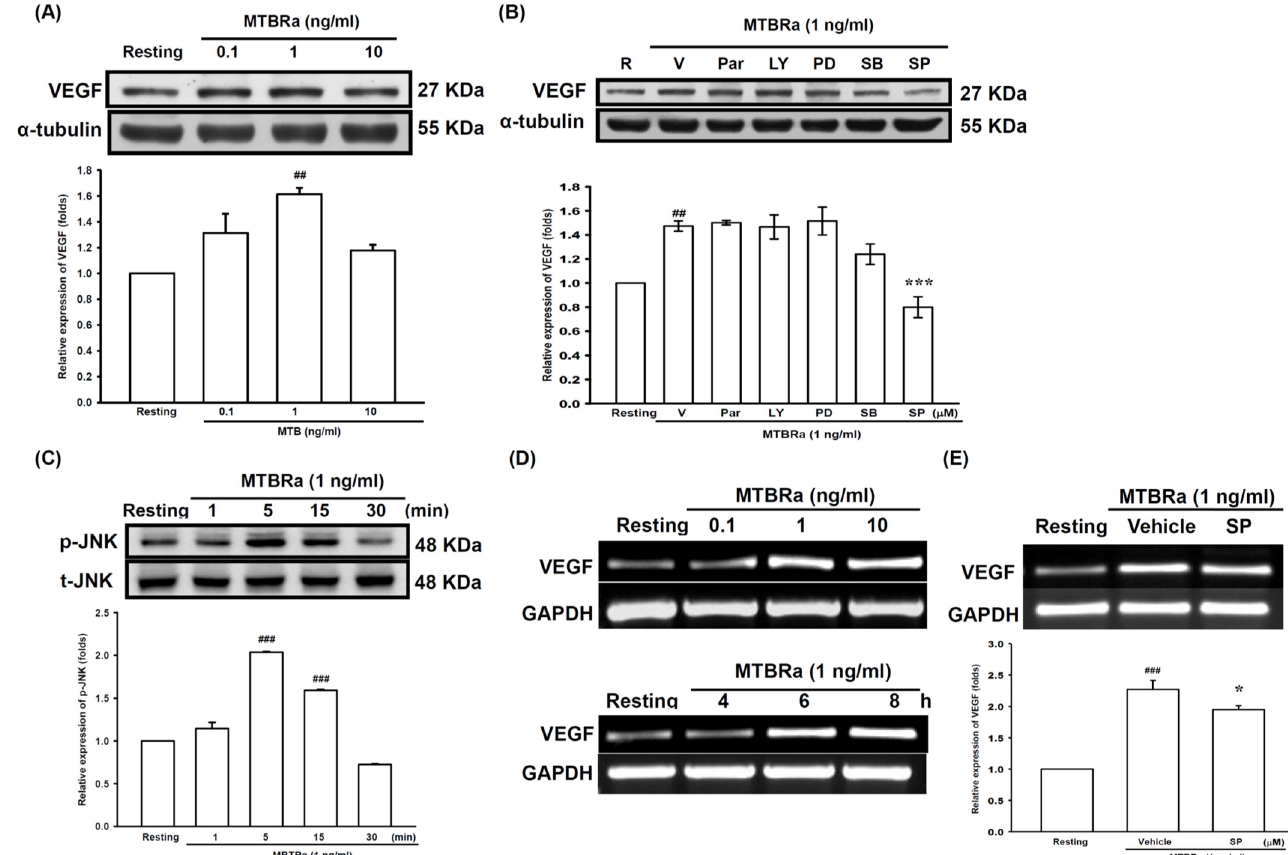
Figure 2. MTBRa induces VEGF expression in human PMCs through JNK signaling. ( A ) MeT-5A cells were treated with MTBRa (0.1–10 ng/ml) for 24 h. VEGF protein was assayed by Western blotting. ## p < 0.01 compared with resting group; ( B ) MeT-5A cells were pretreated with vehicle (V), Parthenolide (Par, 20 µM), LY294002 (LY, 20 µM), PD98059 (PD, 20 µM), SB203580 (SB, 20 µM), or SP600125 (SP, 10 µM), then treated with MTBRa (1 ng/ml) for 24 h. VEGF protein was examined by Western blotting. ## p < 0.01 compared with resting group, *** p < 0.001 compared with vehicle group; ( C ) MeT-5A cells were treated with MTBRa (1 ng/ml) for the specified times, and JNK phosphorylation was assessed by Western blotting. ### p < 0.001, compared with resting group; ( D ) MeT-5A cells were treated with various concentrations of MTBRa (0.1–10 ng/ml) for 8 h or with 1 ng/ml MTBRa for the indicated times. The levels of VEGF mRNA were measured by RT-PCR. ( E ) MeT-5A cells were pretreated with vehicle or SP 10 µM for 15 min, followed by MTBRa treatment. The VEGF mRNA expression was quantified by RT-PCR. ### p < 0.001 compared with resting group; * p < 0.05 compared with vehicle group. The relative folds of densitometrical data of all studies were expressed as mean ± SEM of three independent experiments. VEGF, vascular endothelial growth factor; PMC, pleural mesothelial cell; MTBRa, Mycobacterium tuberculosis H37Ra; JNK, c-Jun N-terminal kinases; GAPDH, glyceraldehyde 3-phosphate dehydrogenase.